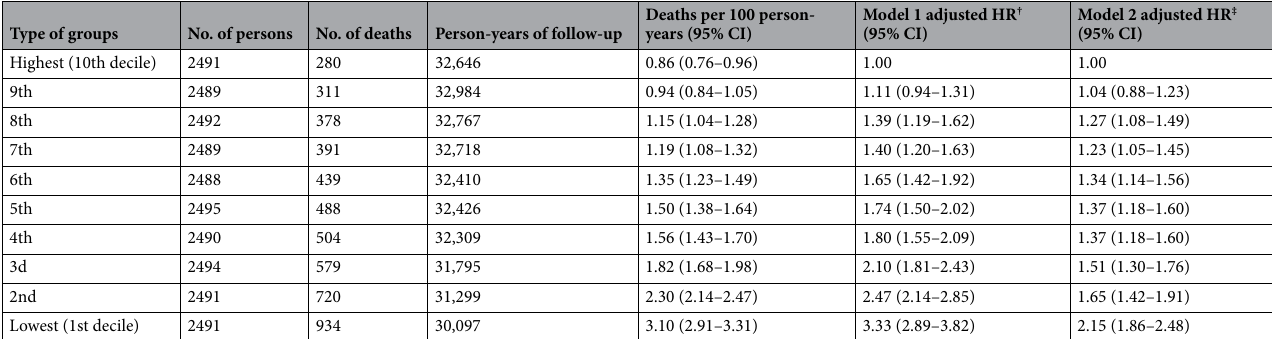
Table 2. Association between FEV1/height 3 deciles and all-cause mortality. FEV1 forced expiratory volume in 1 s, CI confidence interval, HR hazard ratio. † Adjusted for age, sex and country. ‡ Adjusted for occupation and education; alcohol consumption, smoking status, level of physical activity and body mass index; history of hypertension, ischemic heart disease, myocardial infarction, stroke.